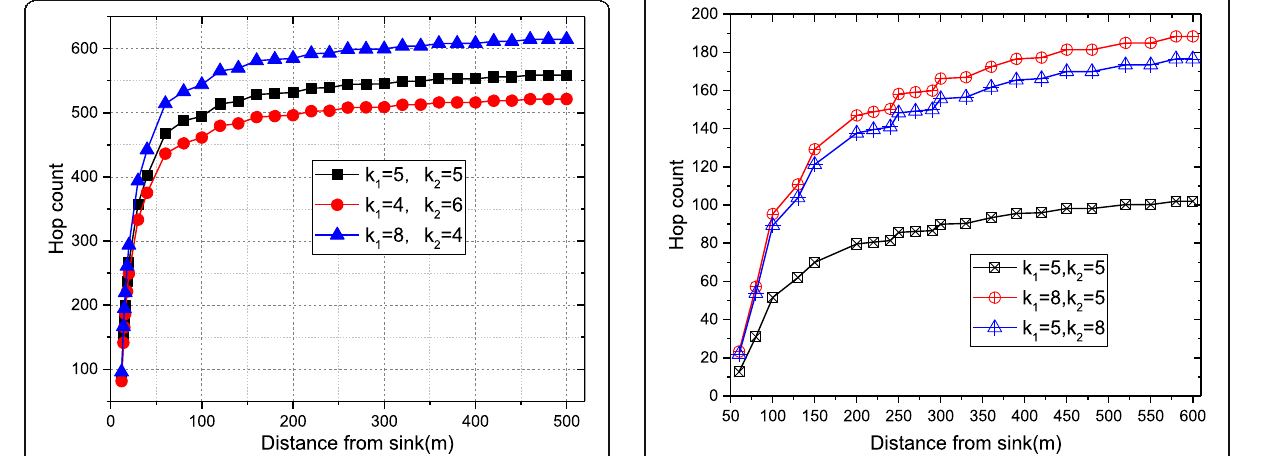
Fig. 16 Number of detection hops created by the remaining energy (different k 1 , k 2 )